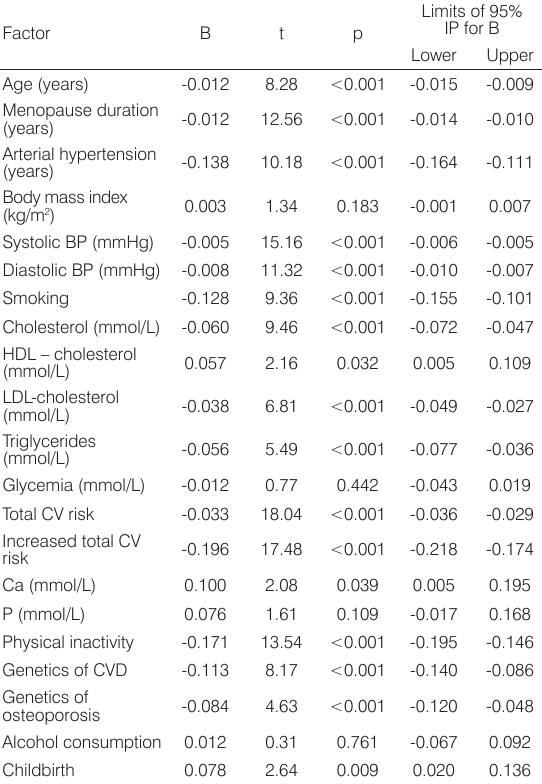
Table 5. Influence of risk factors on bone density; results of univariate linear regression analysis.